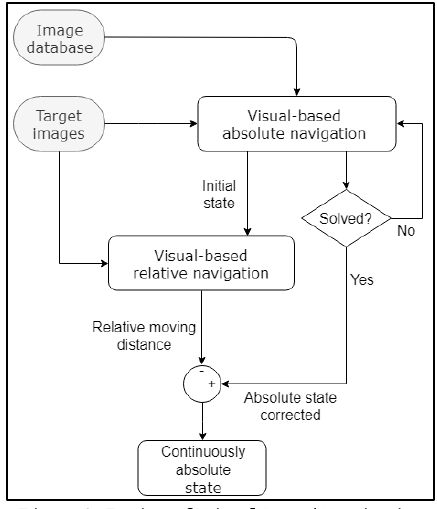
Figure 8. Fusion of Visual-Based Navigation